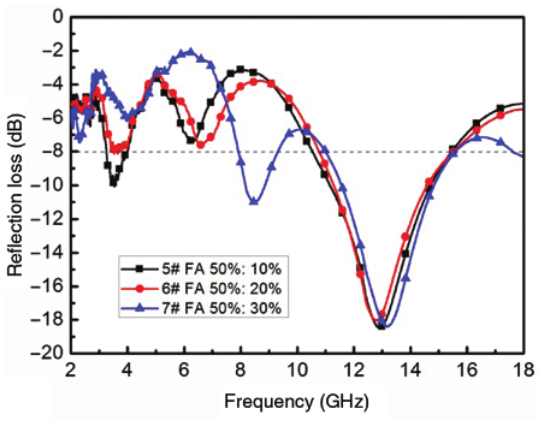
Figure 8: Effect of Ni-Zn ferrite on reflection loss of double-layer cement